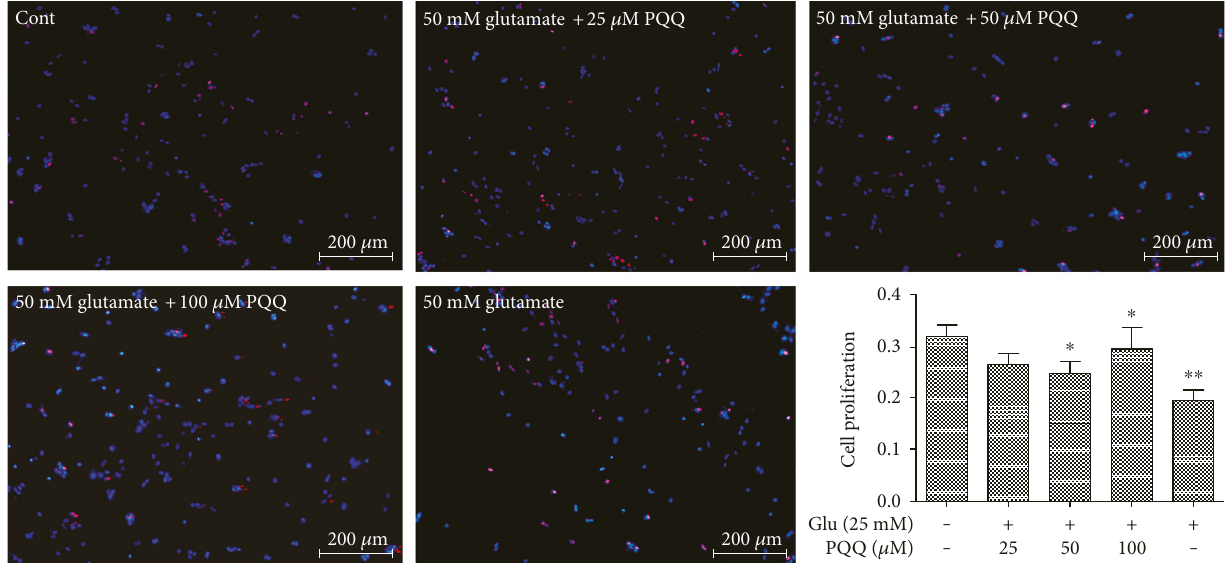
Figure 15: The proliferation of astrocytes with glutamate and PQQ ( ∗ P < 0 05 , ∗∗ P < 0 01 ).